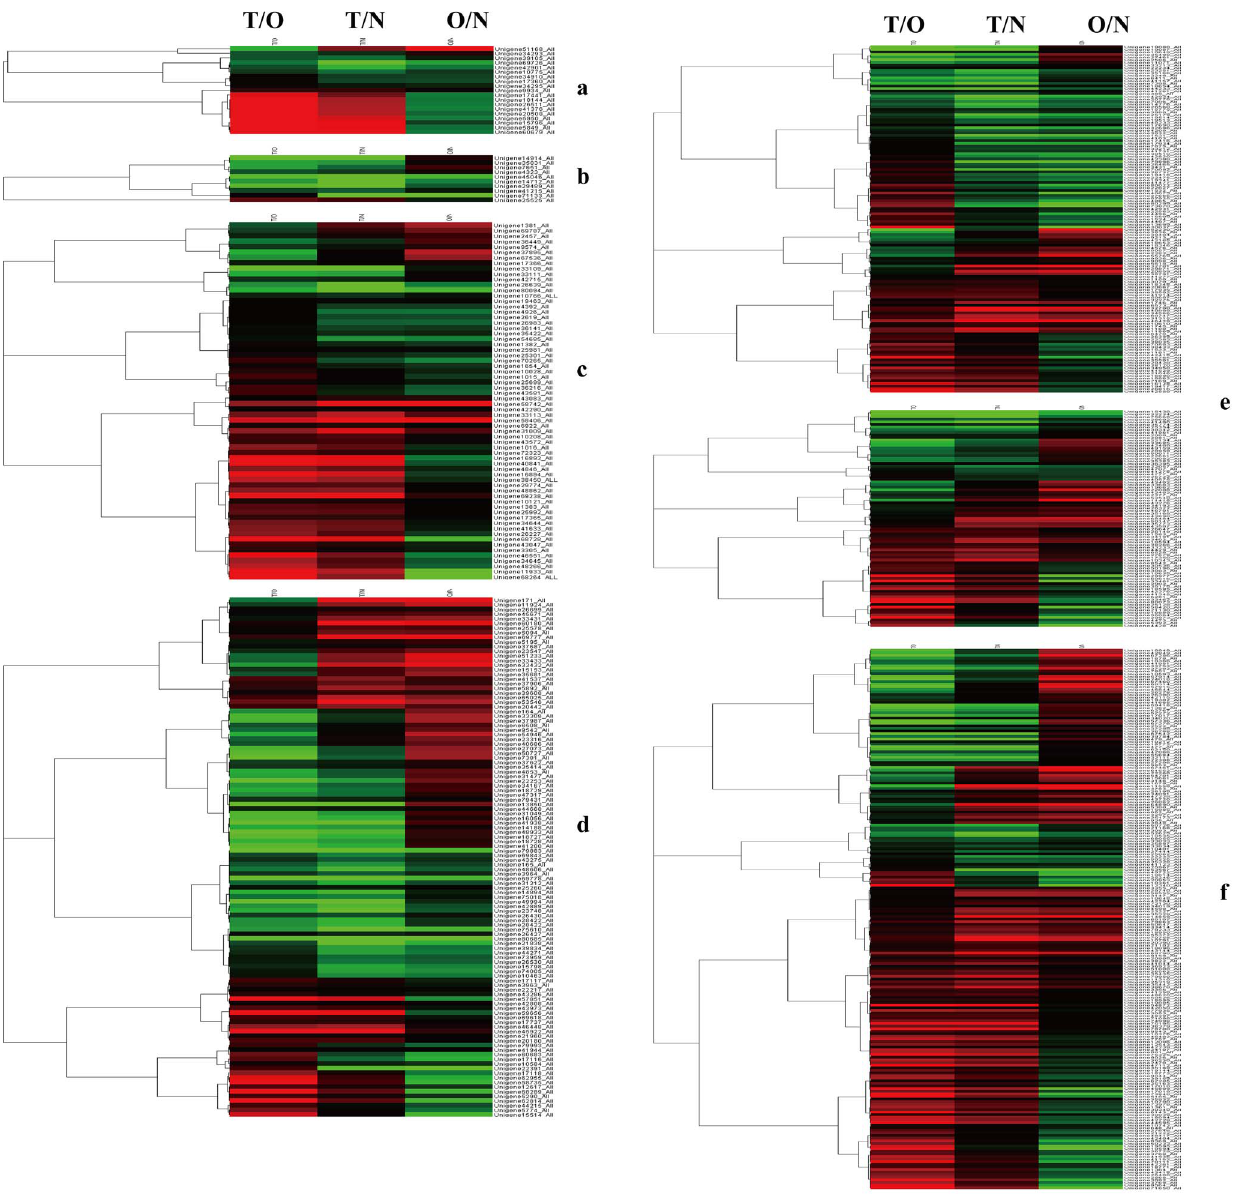
Figure 4. Hierarchical cluster analysis of different gene families with altered expression levels in response to artificial bending. All ratios are log2 transformed so that inductions and repressions of identical magnitudes are numerically equal but opposite in direction. Log ratios of 0 (ratios of 1) are shown in black, and increasingly positive (induction) or negative (repression) log ratios are shown in red or green, respectively, with increasing intensities. Red indicates induction, and green indicates repression in arrays. A: FLA family genes, B: LTP family genes, C: